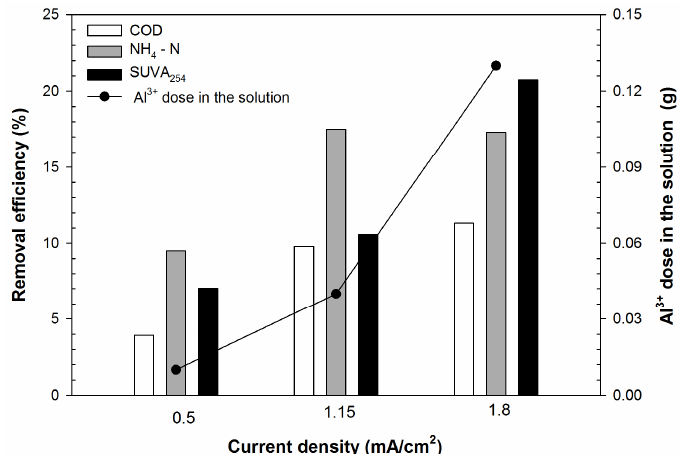
Figure 2. Removal efficiencies of COD, NH 4 -N and SUVA 254 at varying current densities (conditions: initial concentration = 4 mg/L, HRT = 19 h) and concentration of Al 3+ dissolved in the solution at increasing current density.